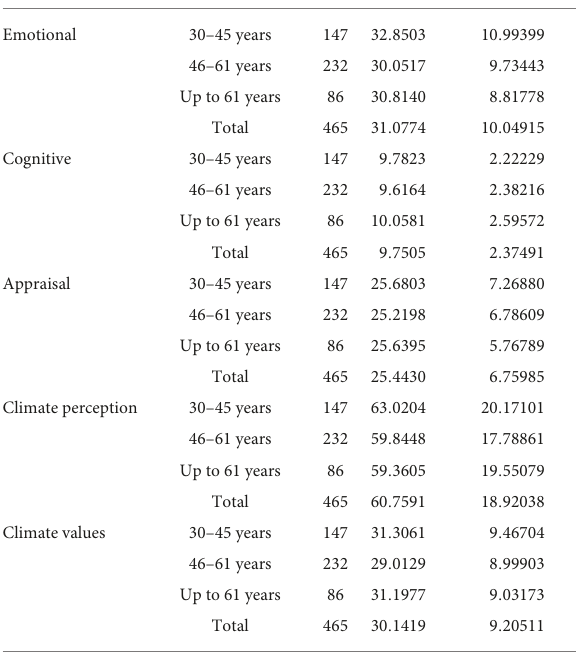
TABLE 7 Multiple comparisons in the emotional subscale of climate change perception (CCP) and CCP total score due to career field variable. Measurement